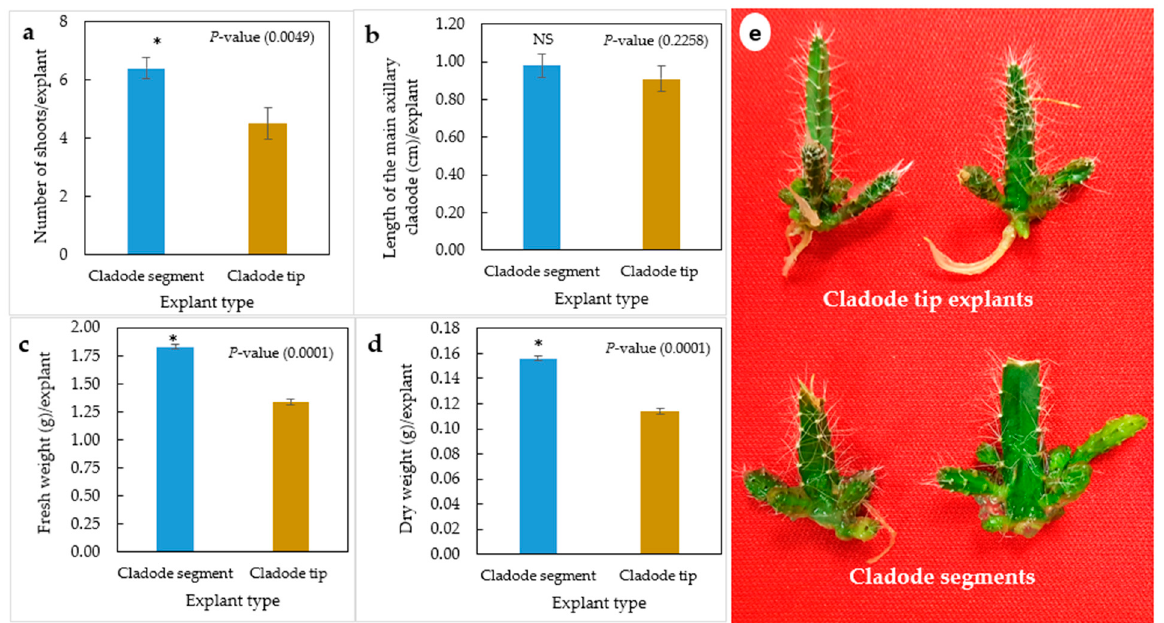
Figure 1. Effect of explant type (cladode segment and cladode tip explants) on multiplication of H. polyrhizus after 8 weeks in culture. ( a ) Number of shoots per explant, ( b ) length of the main axillary cladode per explant, ( c ) fresh weight per explant, ( b ) dry weight per explant and ( e ) photo showing multiplication of cladode segment and cladode tip explants. NS = non-significant, * = significant at p ≤ 0.01.